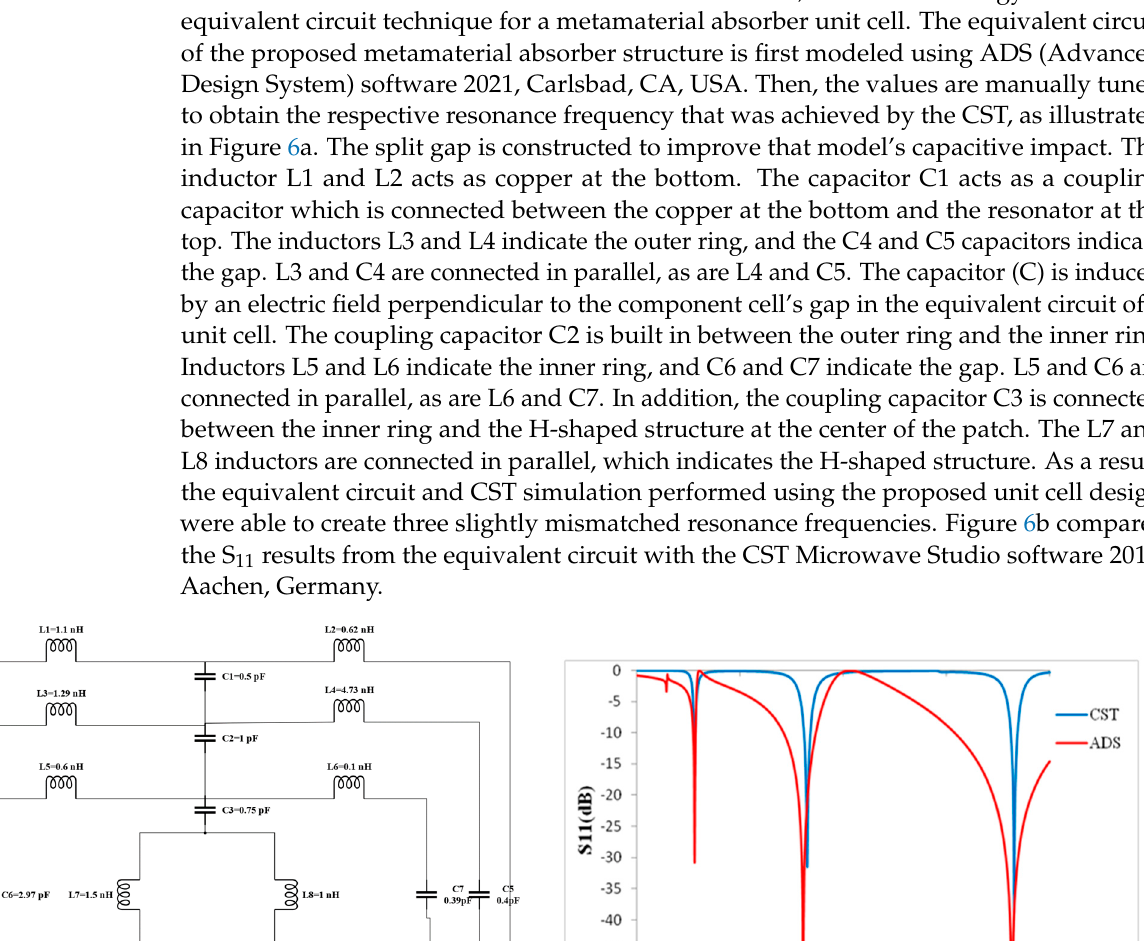
results using ADS and CST simulator. Figure 6. ( a ) Equivalent circuit; ( b ) S 11 11